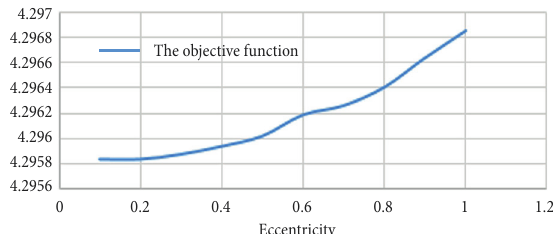
Fig. 6. The value of the objective function versus dilation angle in biaxial compression test